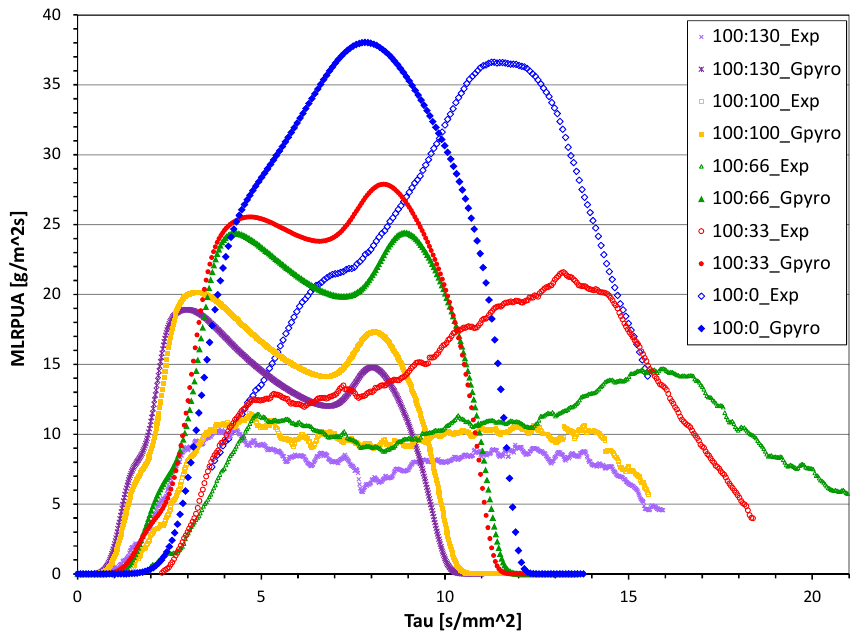
Figure 7. Experimental mass loss rate per unit area (MLRPUA) measured in the Cone Calorimeter and for the Gpyro for each resin and alumina trihydrate (ATH) mixture (Tau is the time divided by sample thickness squared).